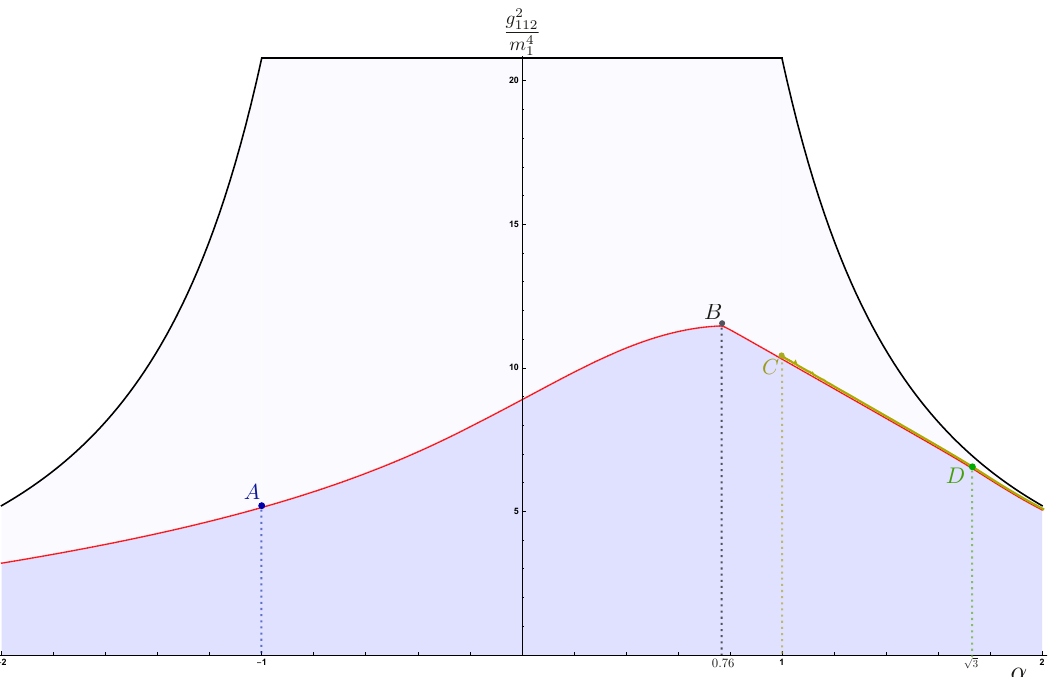
Z Figure 7. Maximum coupling g 112 as a function of (cid:11) = g 222 =g 112 for a 2 symmetric theory with an odd and an even particle both with the same mass. Solid black: bounds from single amplitude analytics. Red: bounds from multiple amplitudes numerics. The interesting points A; B; C; D are discussed in more detail in the next section. Multiplying the (cid:11) axis by g 112 we convert this plot into a plot of the allowed coupling space ( g 112 ; g 222 ), see (cid:12)gure